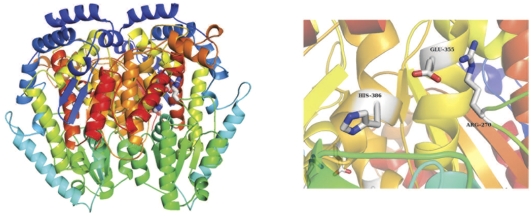
PGI dimer and putative active site.Left, the pGI dimer. Right, close -up view of the active site with putative active site residues colored by atom and labeled. The active site is formed at the dimer interface and has contributions from both monomers.